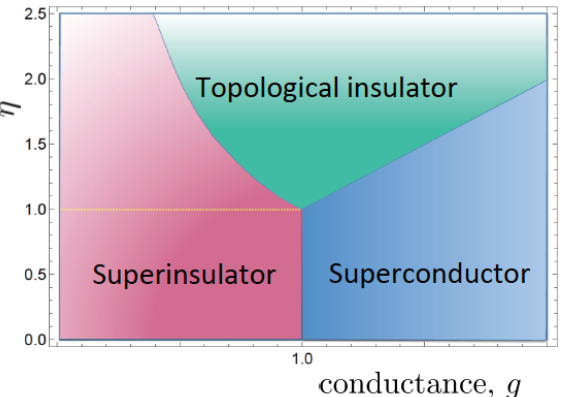
Figure 3. The quantum phase diagram of the SIT as a function of the coupling constant g . The point g = 1, η = 1 is a tricritical point dominating the phase